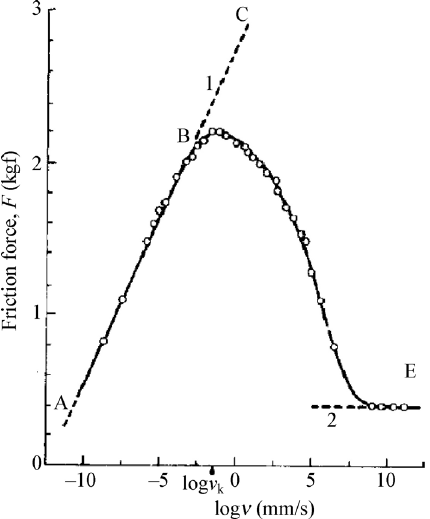
Fig. 6 NEMD simulations of squalane showing the dependence of predicted shear stress and viscosity on strain rate and tem- perature (dashed lines are Eyring fits). Reproduced with permission from [70]. Copyright NAS, 2017.